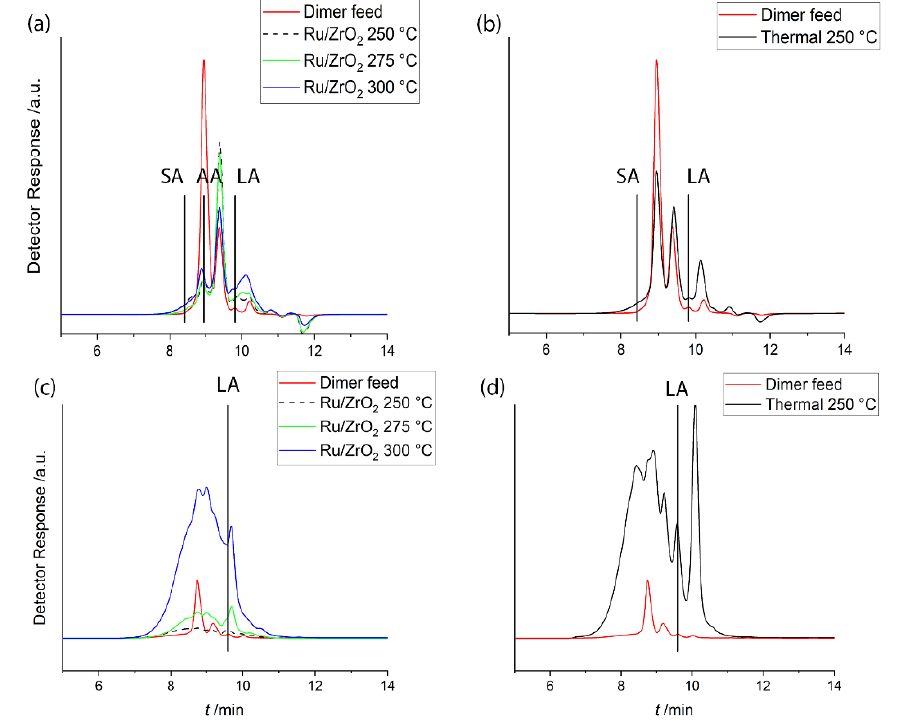
Figure 7. Gel permeation chromatography (GPC) chromatograms of the dimer feed and the products obtained with Ru / ZrO 2 catalyst and thermally at various temperatures. ( a , b ) with refractive index (RI) detector (equal scaling), and ( c , d ) with UV detector (270 nm, equal scaling). SA: stearic acid (284 amu), AA: azelaic acid (188 amu), LA: levulinic acid (116 amu).